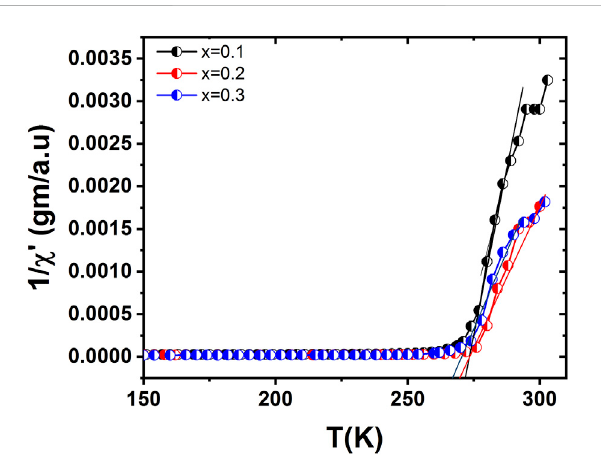
FIGURE 8 Acsusceptibility versus temperatureforLa 1-x Ca x MnO 3 (x=0.1, 0.2, and 0.3) showing different paramagnetic Curie